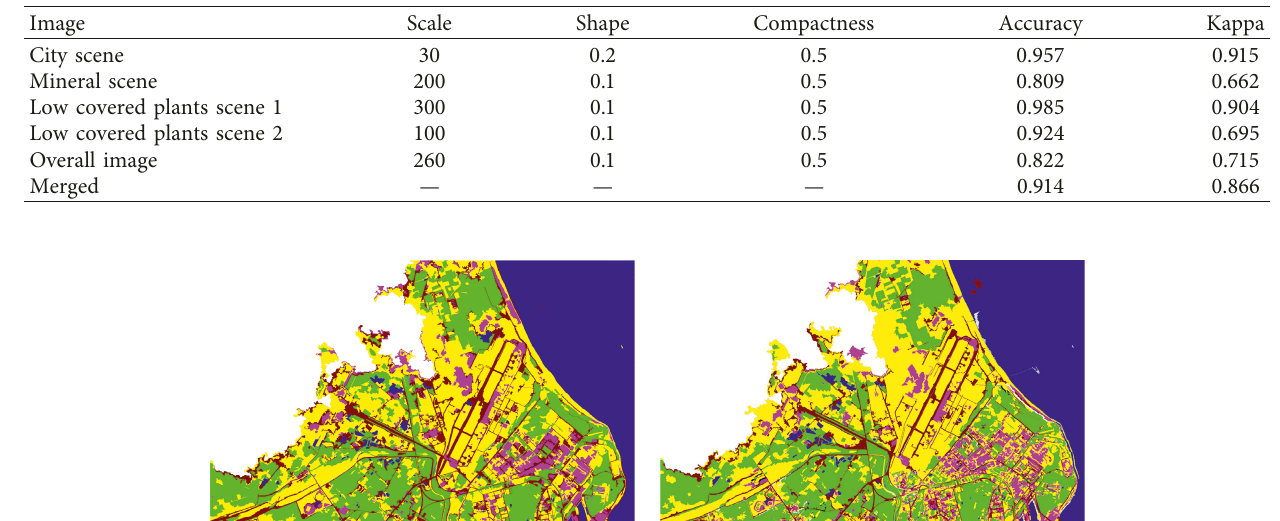
Table 6: The optimal segmentation parameters and classification results for different scenes of image B.